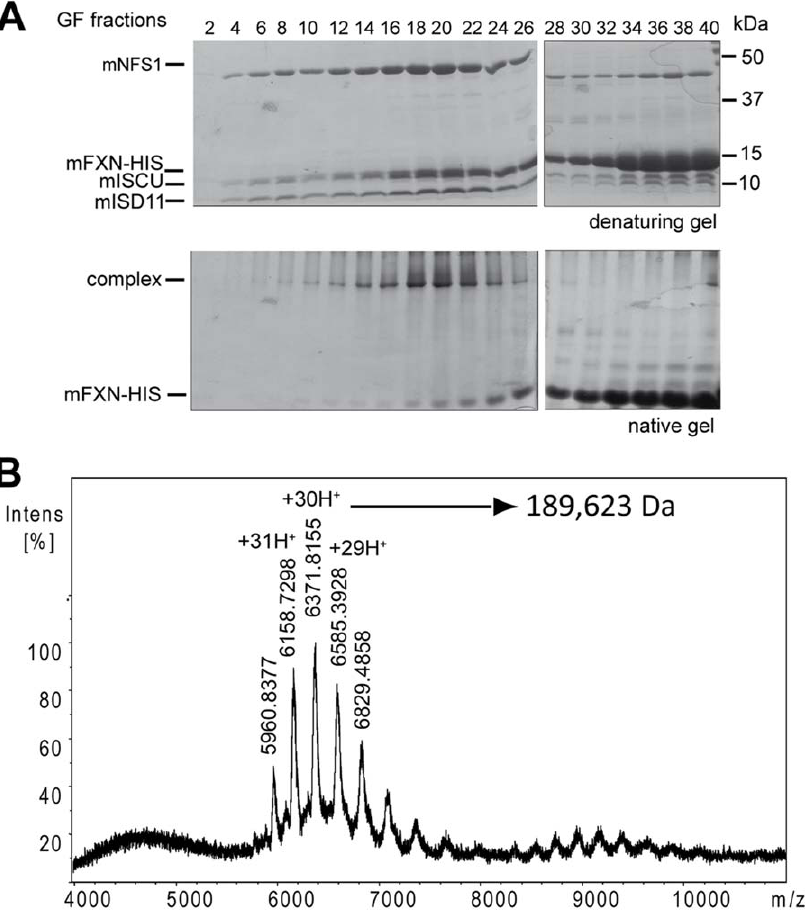
Figure 5. Determination of the molecular weight of the FXN/ISCU/NFS1/ISD11 complex. (A) Gel filtration for the mFXN-HIS/mISCU/ mNFS1/mISD11 complex. After a single nickel column purification, the sample was loaded and separated by gel filtration. Coomassie staining of a denaturing and a non-denaturing gel corresponding to fractions 2 to 40 are shown. Fractions 19 and 20 that contained the complex were concentrated for the native mass spectrometry analysis. (B) ESI native mass spectra of the mFXN-HIS/mISCU/mNFS1/mISD11 complex after gel filtration purification. The experimental molecular weight for each component was 10,722 Da, 14,543 Da, 15,333 Da and 44,669 Da for mISD11, mISCU, mFXN-HIS and mNFS1, respectively. The mass was estimated to the molecular weights of 189,623 Da.